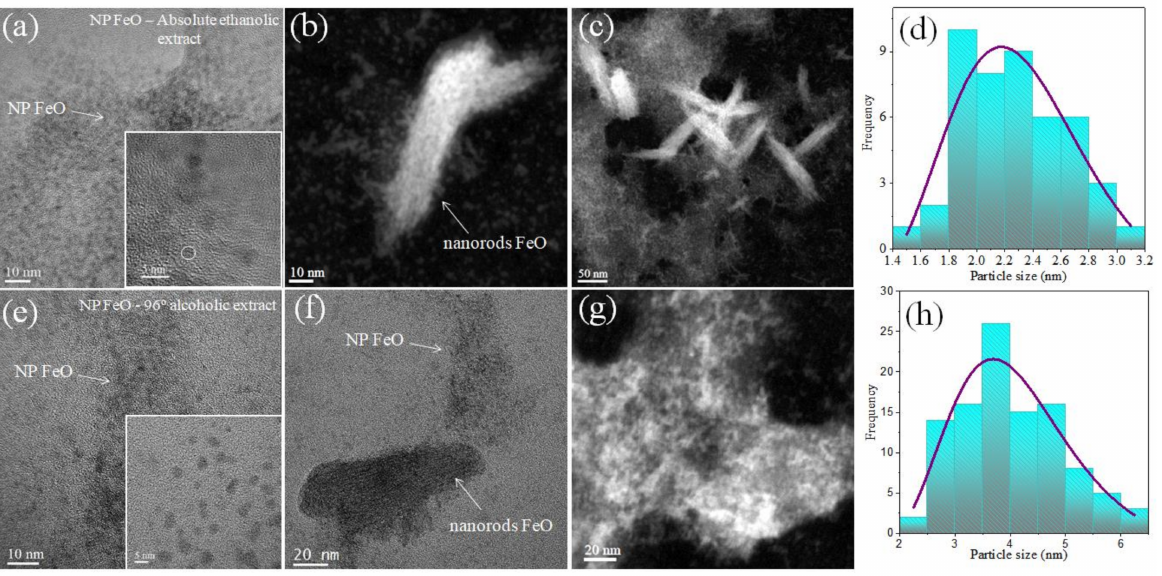
Figure 7. STEM characterization and size histograms of FeO NPs using extracts of E. globulus in solvent, ( a – d ) the absolute ethanol solvent and ( e – h ) the 96% alcohol